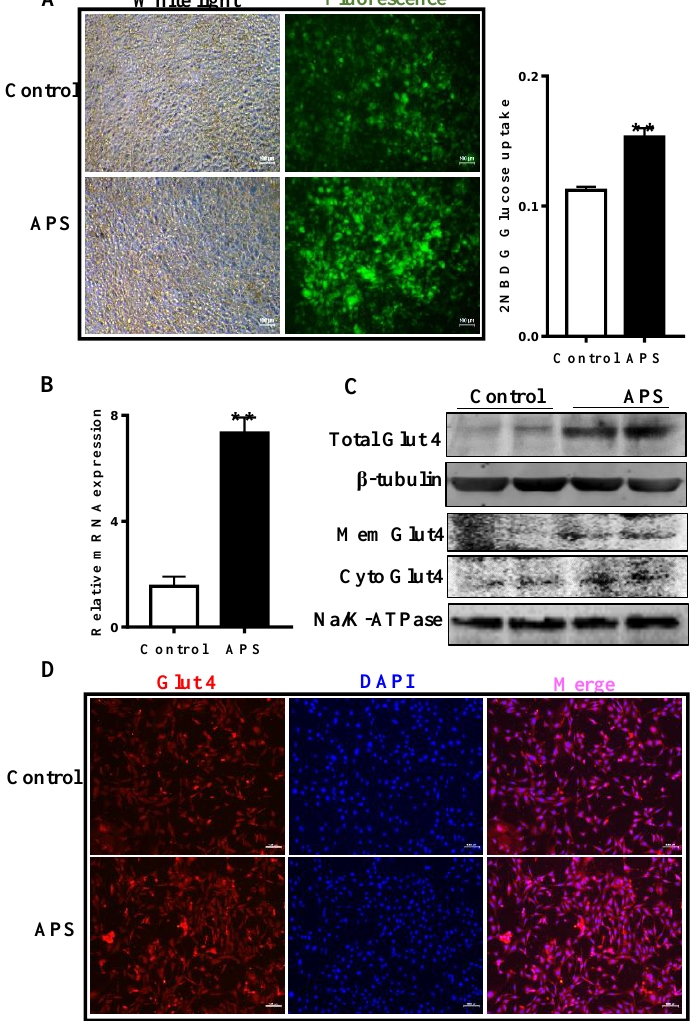
Figure 3. APS stimulated glucose uptake and increased the expression of glucose transporter 4 (Glut4) in adipocytes. ( A ) 2-( N -(7-Nitrobenz-2-oxa-1,3-diazol-4-yl)Amino)-2-Deoxyglucose (2-NBDG) uptake assay, data show that APS promoted glucose uptake in fully differentiated adipocytes. ( B ) mRNA in differentiated adipocytes treated with or without APS. ( C ) Total, membrane and cytoplasmic Glut4 content in different groups. ( D ) Immunocytochemical staining of Glut4. n = 6, ** p <